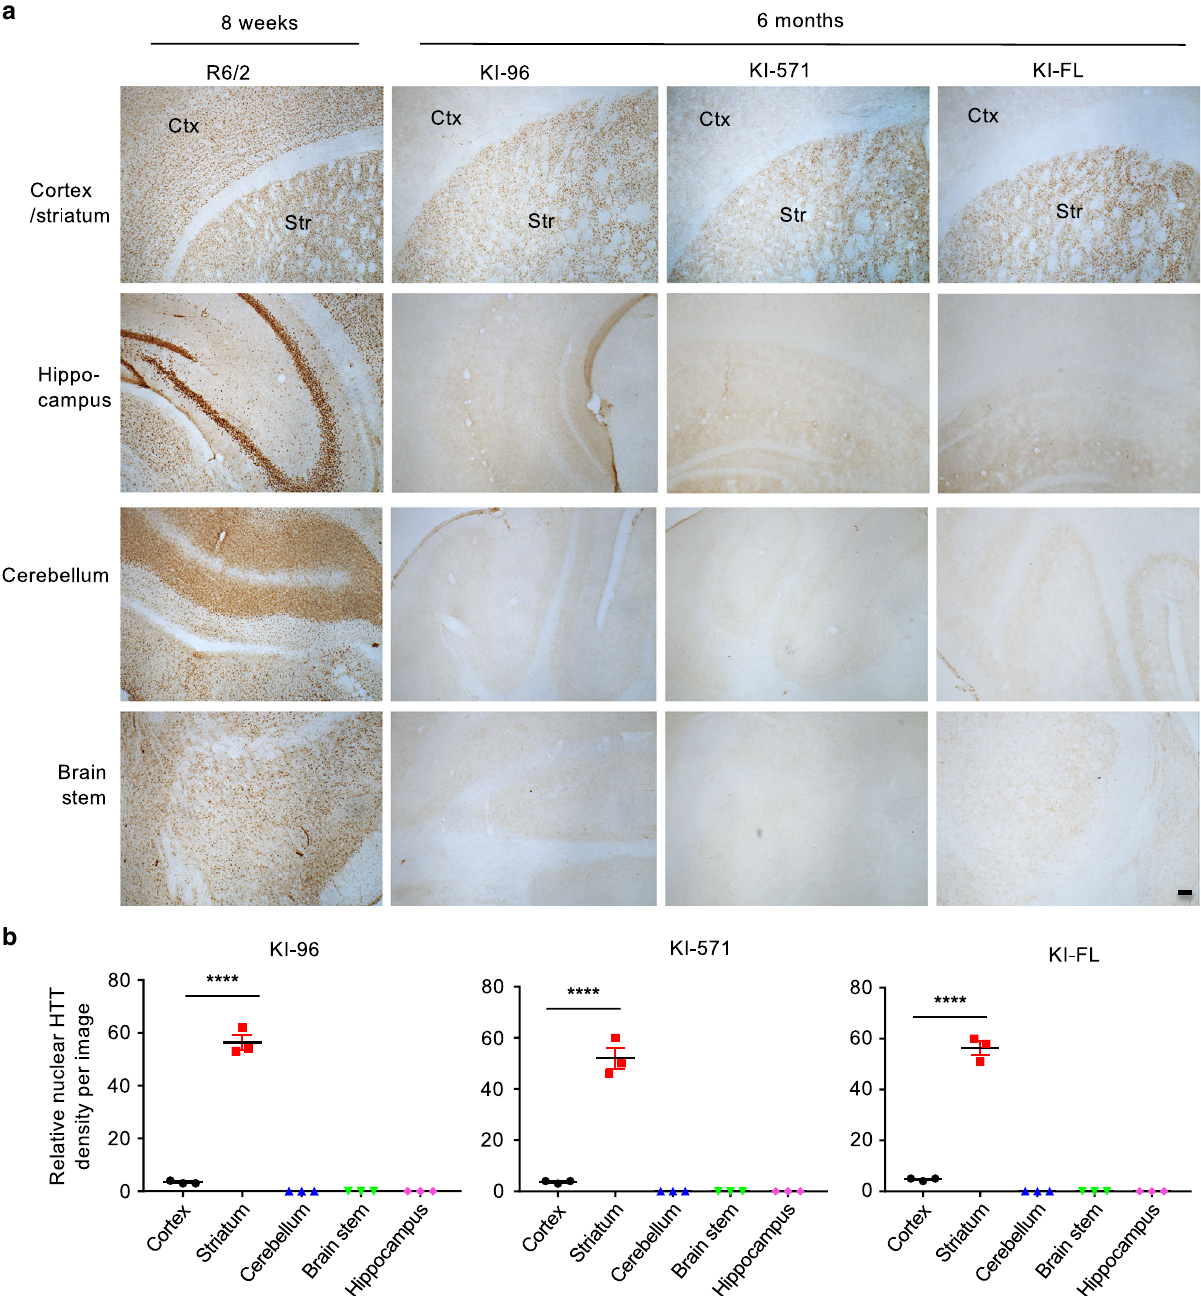
Fig. 3 Preferential accumulation and aggregation of mutant HTT in the striatum of different KI mice. a Comparison of mEM48 staining of various brain regions in R6/2 and KI (KI-96, KI-571, KI-FL) mice showing the preferential accumulation of mutant HTT in the striatum of KI mice. The micrographs (5×) from the striatum (Str), cortex (Ctx), hippocampus, cerebellum, and brain stem are presented. Scale bar: 100 μ m. b Quantitative analysis of density of mEM48 labeled nuclei in different brain regions in KI mice. The data were obtained by counting six images per brain region per mouse ( n = 3 mice per genotype, **** p < 0.0001, one-way ANOVA followed by Tukey ’ s multiple comparison tests, KI-FL, F = 405.5, p < 0.0001; KI-571, F = 150.3, p < 0.0001; KI-96, F = 375.9, p < 0.0001). Data are presented as mean values ± SEM. Source data are provided as a Source Data fi generated from proteolytic cleavage of full-length or a longer HTT protein fragments.